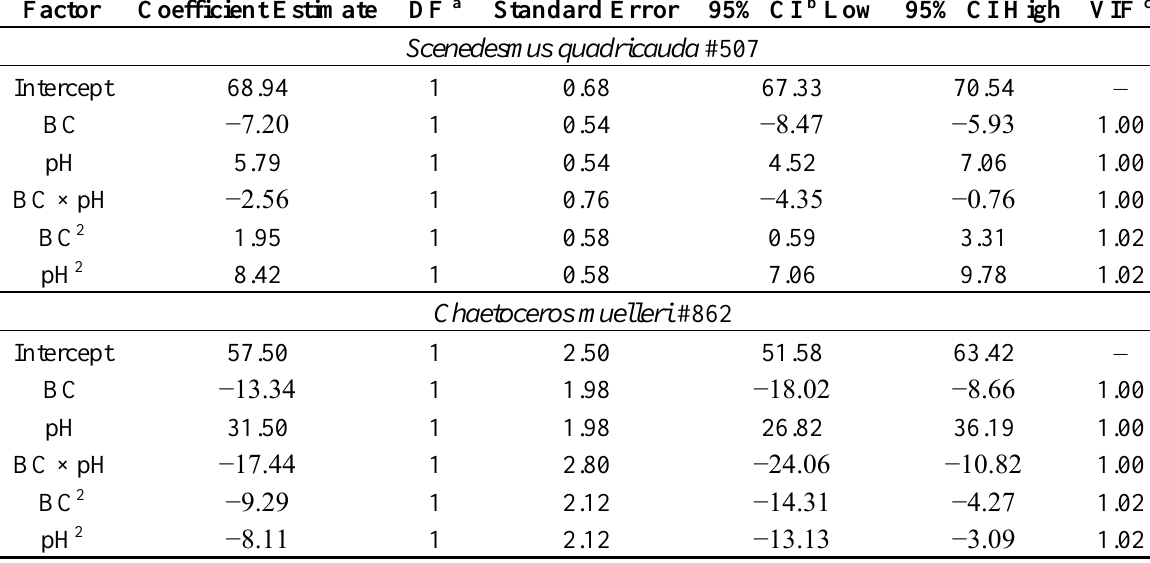
Table 2. Estimated regression coefficients for flocculating